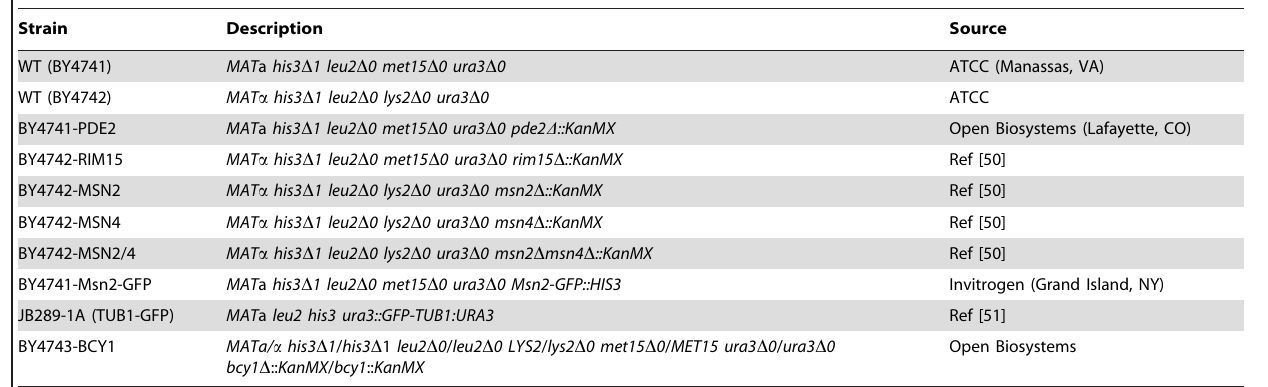
Table 1. Strains used in this study.